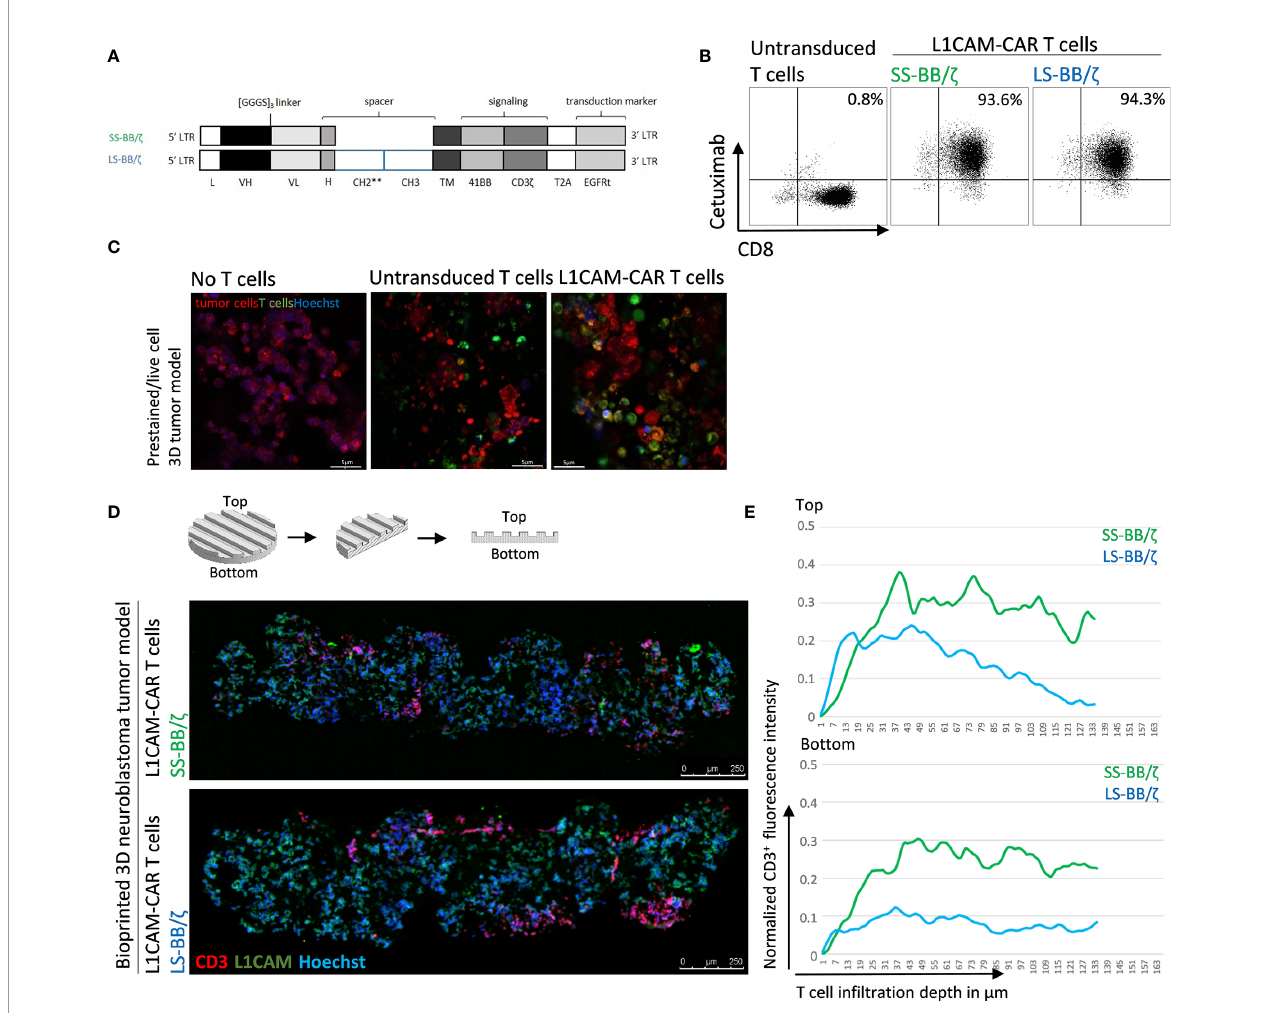
FIGURE 3 | L1CAM-speci fi c CAR T cells in coculture with bioprinted 3D neuroblastoma tumor model. (A) Schematic representation of lentiviral constructs used to generate L1CAM-speci fi c second-generation CAR T cells. L, long-terminal repeat; VH, variable region of the heavy chain; VL, variable region of the light chain; H, hinge region with either short (IgG4) or long (CH2**-CH3) spacer; CH2**, CH2 harboring both L235D and N297Q point mutations; TM, transmembrane domain; T2A, virus 2A self-cleaving sequence. (B) Representative fl ow cytometry plots showing EGFRt transduction marker expression on CD8+ T cells transduced with L1CAM- speci fi c short spacer 4-1BB zeta (SS-BB/ z ) and long spacer 4-1BB zeta (LS-BB/ z ) constructs after enrichment. Untransduced T cells served as negative control. (C) Live-cell imaging of prestained bioprinted 3D tumor models (lower panel) alone (prestained with CellTracker ™ Red CMTPX, red and Hoechst, blue) or in coculture with untransduced or LS-BB/ z T cells (prestained with CellTracker ™ Green CMFDA, green, and Hoechst, blue) using confocal microscopy (E:T = 5:1) Scale bar = 5 μm. (D) Schematic depiction of 3D print and FFPE sample processing and orientation. Immuno fl uorescence staining of formalin- fi xed paraf fi n-embedded (FFPE) 3D tumor models treated with L1CAM-CAR T cells for CD3 (red), L1CAM (green) and Hoechst (blue). Schematic 3D print serves for orientation; Scale bar = 250 μm. (E) T cell in fi ltration depth quanti fi ed by red fl uorescence channel pro fi ling. Staining intensity is depicted as normalization of CD3+ T cells fl uorescence intensity on the y- axis, and T cell in fi ltration depth into the bioprinted 3D tumor is represented on the x-axis. Top indicates the upper model surface containing the channels. Bottom indicates the fl at lower model surface. Depicted is the mean of three distinct areas from biological Figure 4C ). Enzymatic digestion also did not remove CD3 + and expression of the L1CAM and GD2 surface antigens on neuroblastoma cells as well as CD3 + and CD8 + surface CD8 + surface molecules from L1CAM-speci fi c CAR T cells molecules on L1CAM-speci fi c CAR T cells and untransduced T ( Supplementary Figure 2A ) or untransduced T cells (CD3 + : cells after enzymatic digestion. L1CAM expression on SK-N-BE(2) digested: 98.8 ± 0.4%, undigested: 97.9 ± 1.6%; CD8 + : digested: cells digested from 2D or bioprinted 3D models did not differ from 96.2 ± 0.1%, undigested: 96.0 ± 1.7%; Figure 4D ). These data undigested SK-N-BE(2) cells (digested 2D: 79.0 ± 1.1%, digested demonstrate that bioprinted 3D tumor models and target-speci fi c 3D: 88.3 ± 1.7%, undigested 2D: 83.2 ± 1.5%; Figure 4C ). Similar CAR T cells maintain their cell viability and, importantly, their results were obtained for GD2 expression (digested 2D: 95.4 ± surface molecule expression during sample preparation for single- 2.8%, digested 3D: 96.1 ± 0.5%, undigested 2D: 95.7 ± 3.3%; cell suspensions following experiments conducted in the